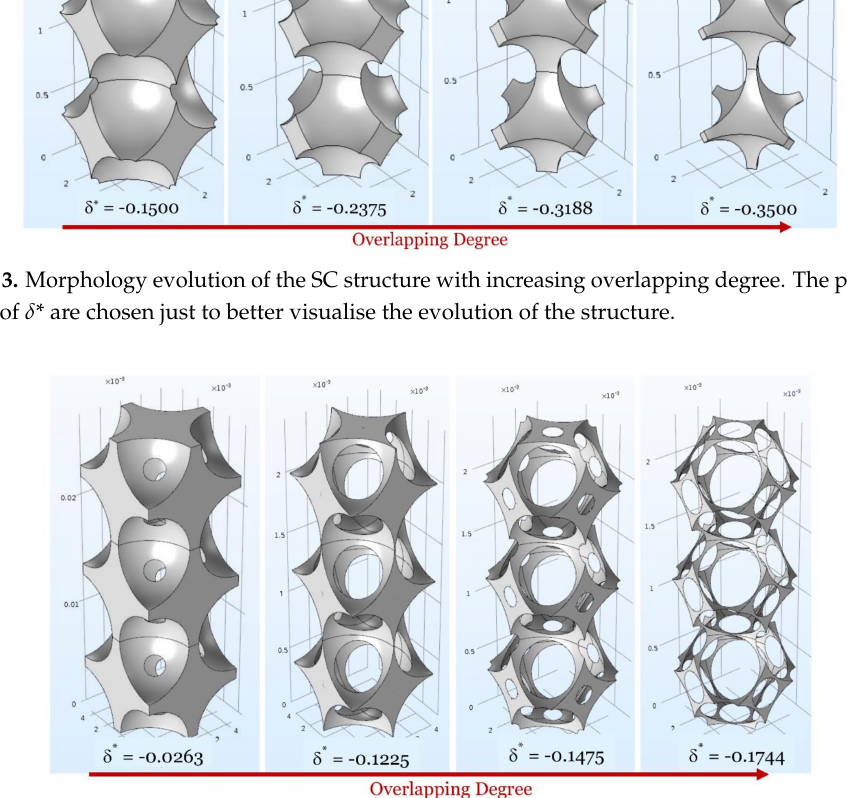
Figure 4. Morphology evolution of the BCC structure with increasing overlapping degree. The particular values of δ * are chosen just to better visualise the evolution of the structure.